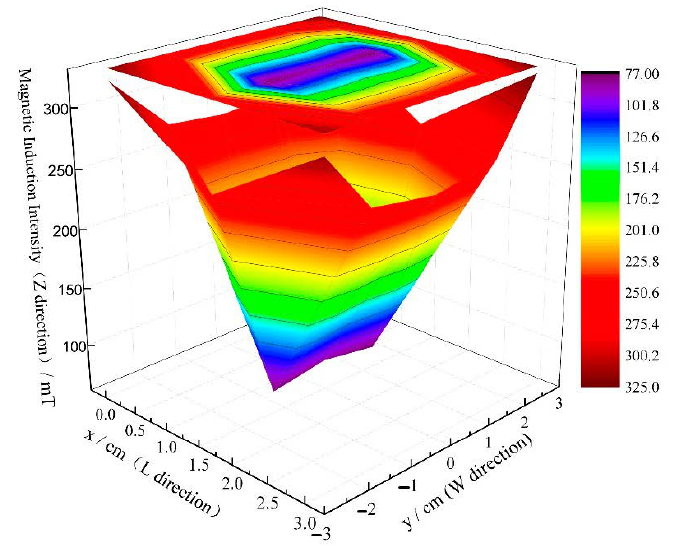
Figure 4. The distribution of magnetic intensity along the thickness direction of the magnet surface.